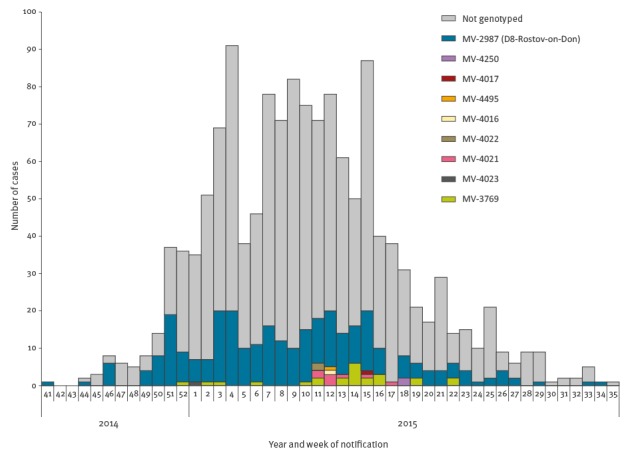
Measles virus sequence variants (given by the ‘distinct sequence identifier’) by reporting week of cases in a large outbreak in Berlin, October 2014–August 2015 (n = 322)